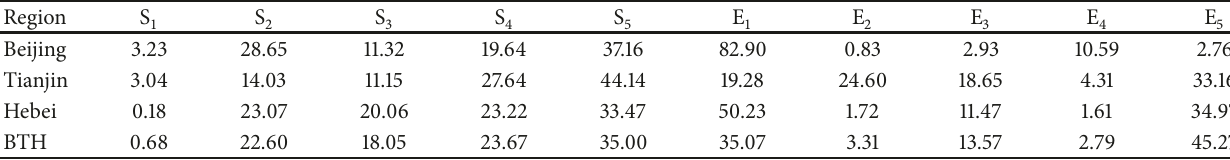
Table 3: Evaluation weight for each indicator in each region.